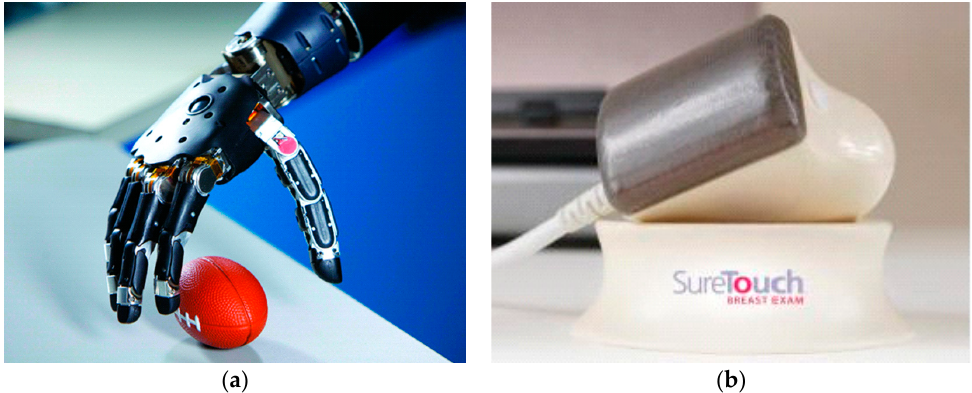
Figure 2. Two examples of tactile sensing systems for biomedical engineering: ( a ) the modular prosthetic limb; and ( b ) the SureTouch sensor for breast exam [120,121] (Reprinted with permission. Copyright 2015 IEEE).